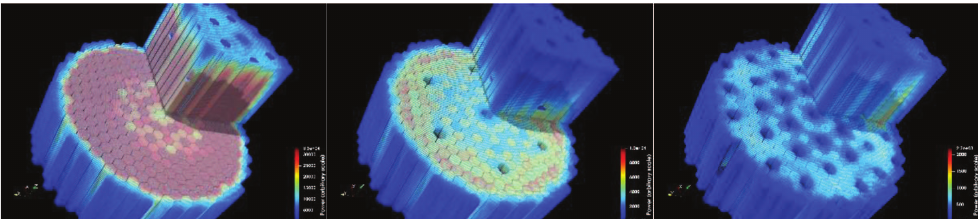
Fig. 1. Power distribution in the core of Paks NPP Unit 4 campaign 32-rod drop experiment beginning state (left), halfway (middle), and end state (right).